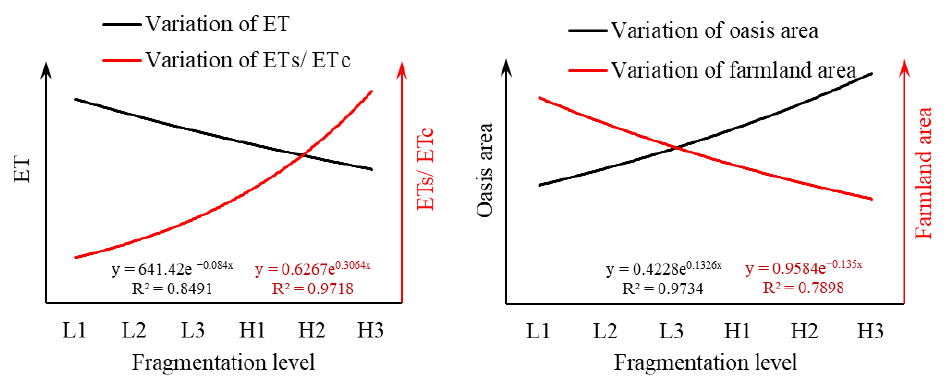
Figure 8. Relationship between ET, ETs/ETc, oasis area, farmland area, and cultivated land frag- tation mentation degree.